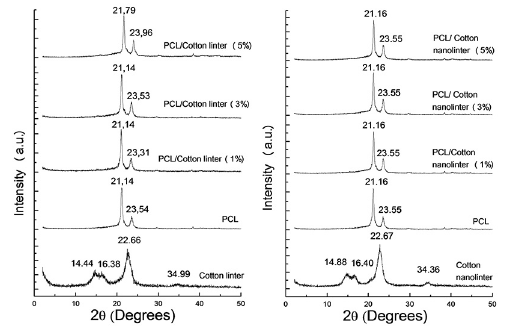
Figure 2: X ray diffratograms cotton linter, cotton nanolinter, PCL, PCL/cotton linter and PCL/cotton nanolinter compounds. Cotton linter and its compounds (a), Cotton nanolinter and its compounds (b) (Compositions indicated). Cotton linter and cotton nanolinter presented peaks around 14.44°, 16.38°, 22.66° e 34.99°, corresponding to